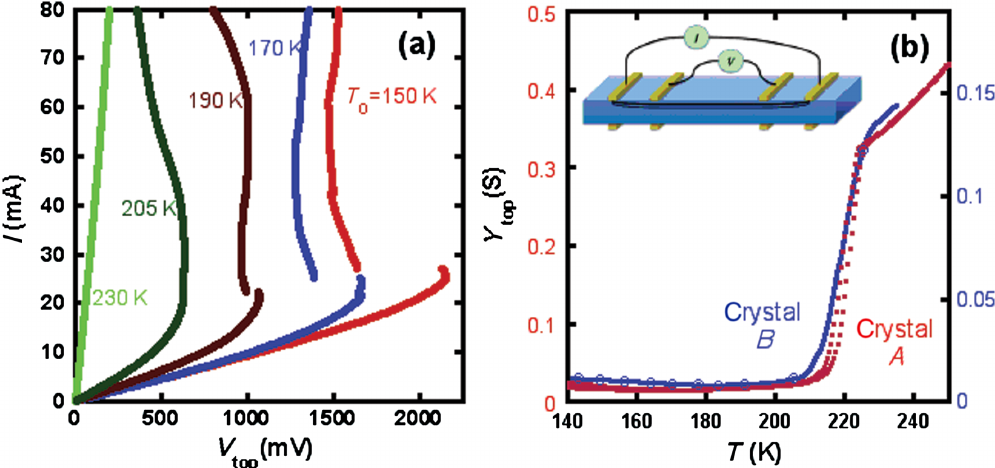
FIG. 3. (a) Current-voltage curves for crystal A at various indicated bath temperatures. (b) Temperature dependence of conductance measured in the four-terminal method (inset) for crystals A and B